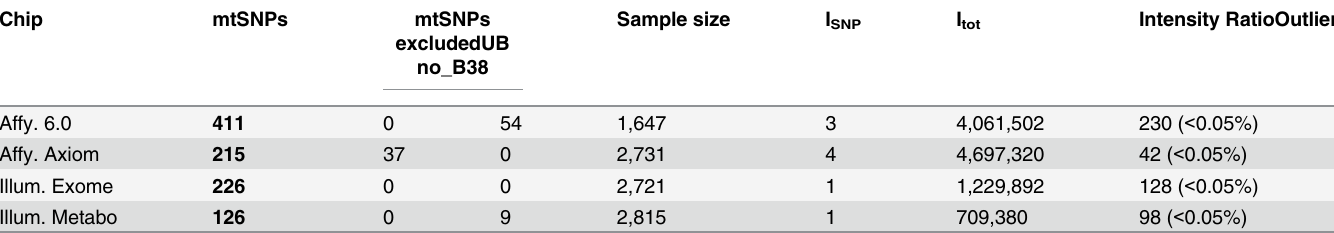
Table 2. Summary of the quality